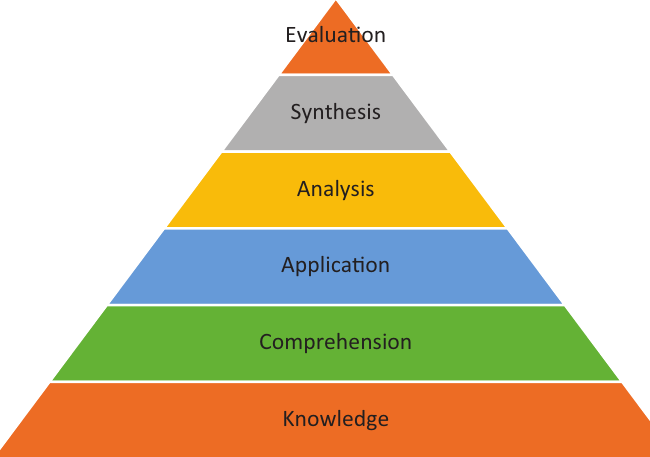
Figure 1. Bloom’s taxonomy. Source: Adapted from Bloom (1956). to map a possible training itinerary in the new journal‐ ism degrees.